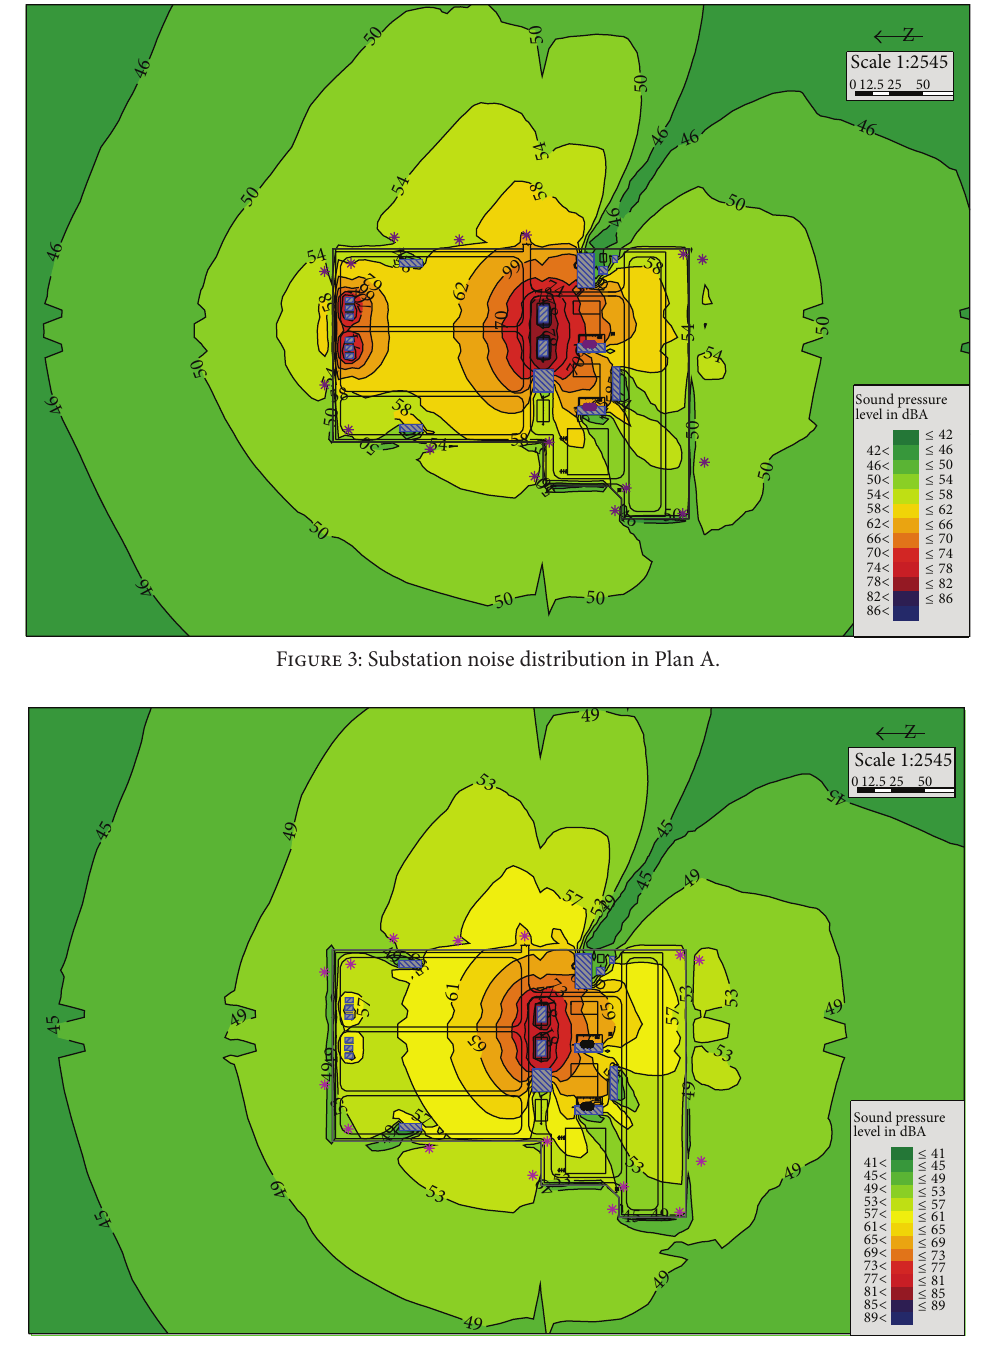
Figure 4: Substation noise distribution in Plan